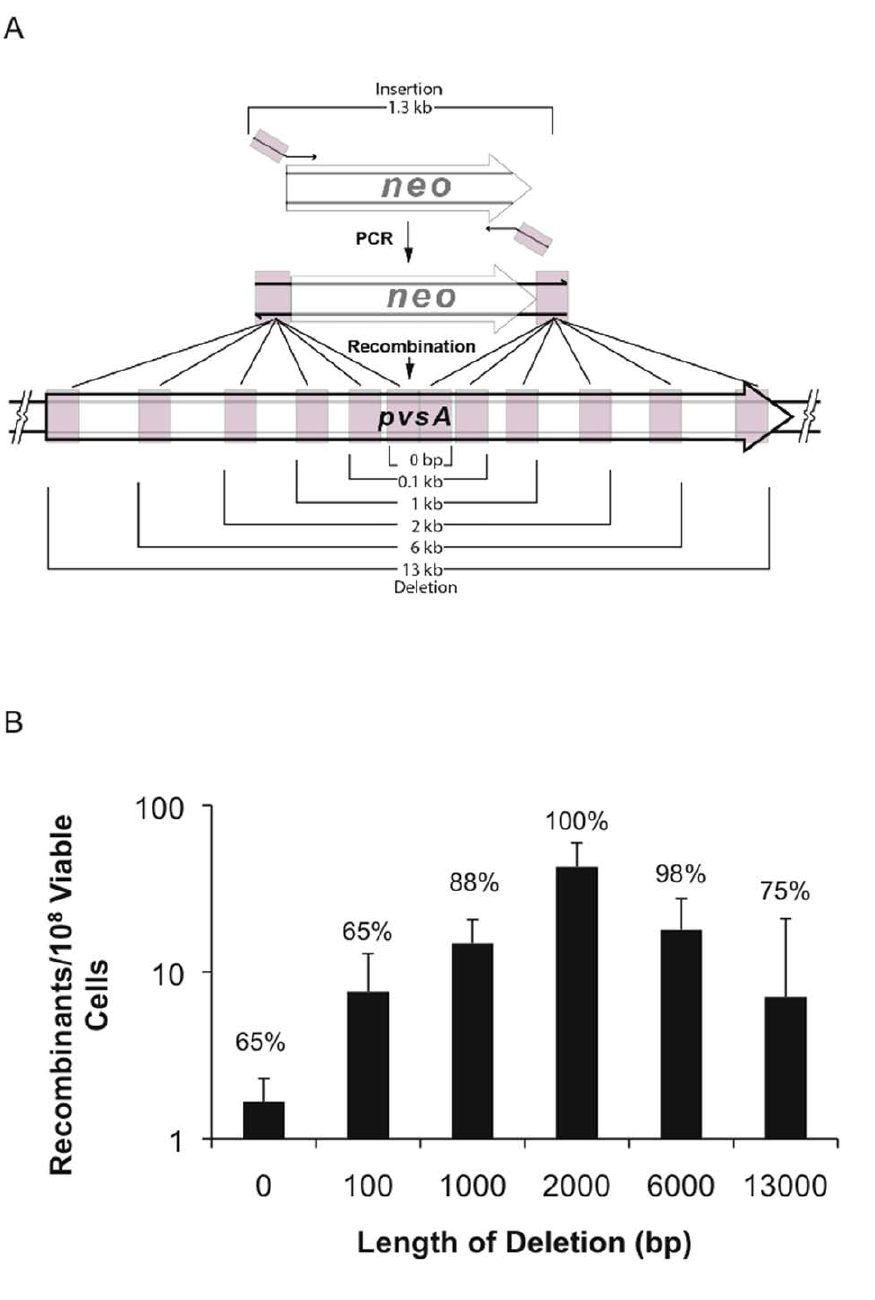
Figure 4. Deletion size affects RecTE Psy -mediated recombination efficiency. (A) Recombination substrates were generated using PCR primers to amplify the neo gene with 80 nt homologies to the pvsA gene at the ends of the PCR product. The size of the deletion is determined by the distance between the pvsA flanking sequences as they exist on the P. syringae DC3000 genome. Homologous sequences are shown in pink. 500 ng of each substrate was used in electroporations. (B) Recombineering efficiency was determined for each substrate. Between 20 to 60 kanamycin resistant clones from each deletion length were analyzed using PCR to determine whether the neo gene had integrated and produced a deletion in the correct location. The percentage of kanamycin resistant clones with the correct deletion is indicated above each bar. The results are the average of four independent replicates, error bars indicate standard deviation.